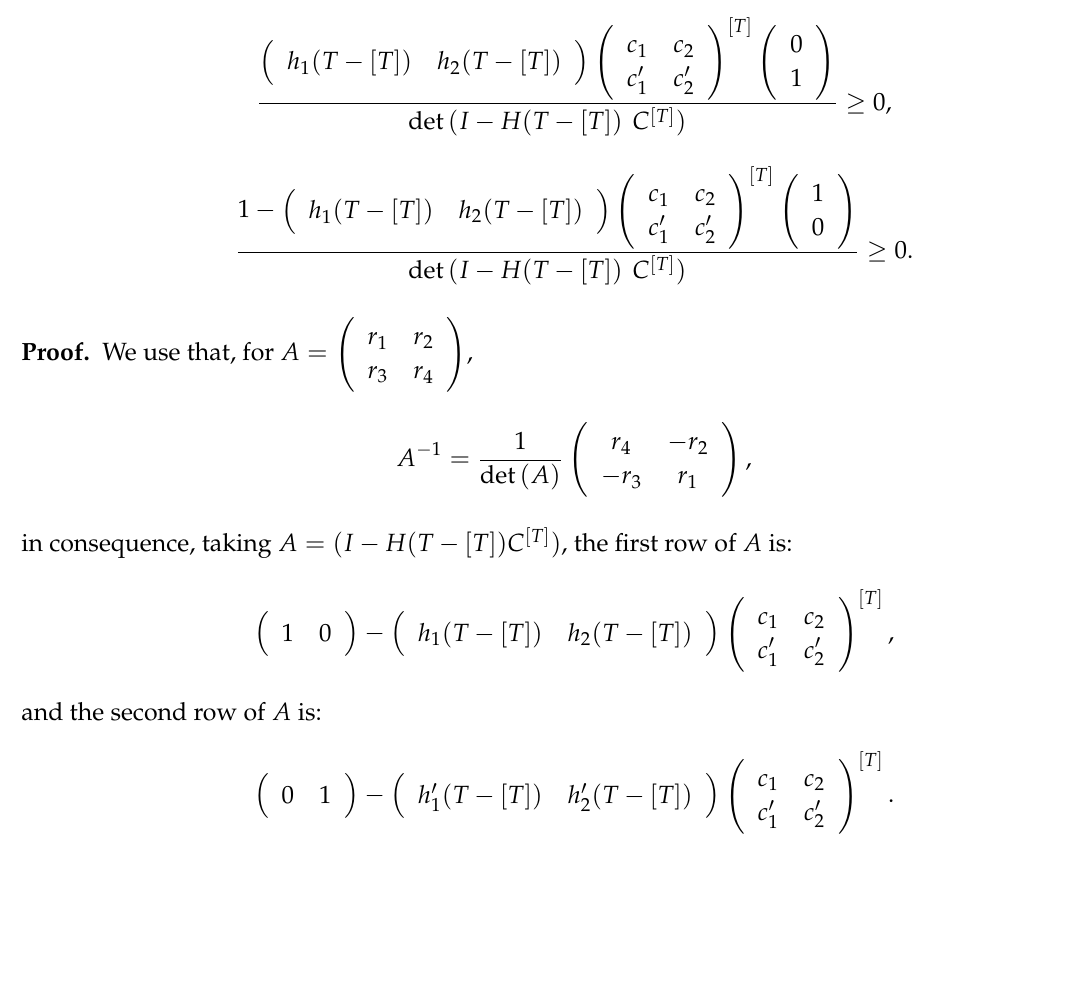
for R = 3 π , a = 7, b = R 2 + a 2 2 2